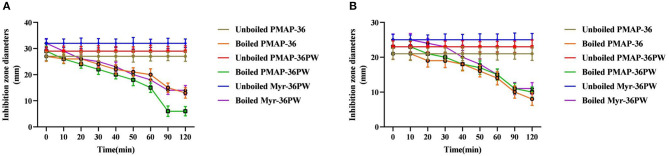
Thermal stability determination of Myr-36PW by boiling. Thermal stability test of Myr-36PW and its analogs by boiling in different times (0, 10, 20, 30, 40, 50, 60, 90, and 120 min) via disk diffusion method. (A) (S. aureus ATCC 25923) and (B) (P. aeruginosa GIM 1.551) show the thermal stability curves of PMAP-36, PMAP-36PW, and Myr-36PW. The diameter of the standard disk is 6 mm. Data represent the mean ± SD (n = 5).